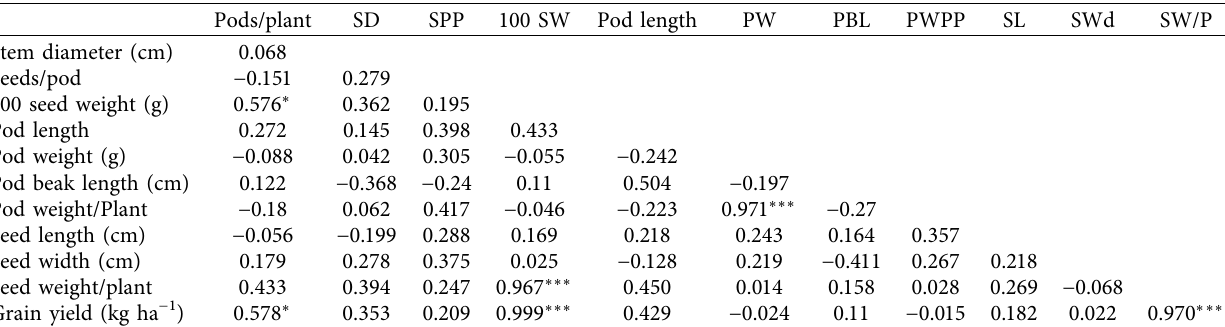
Table 8: Association of morphological traits of African yam bean